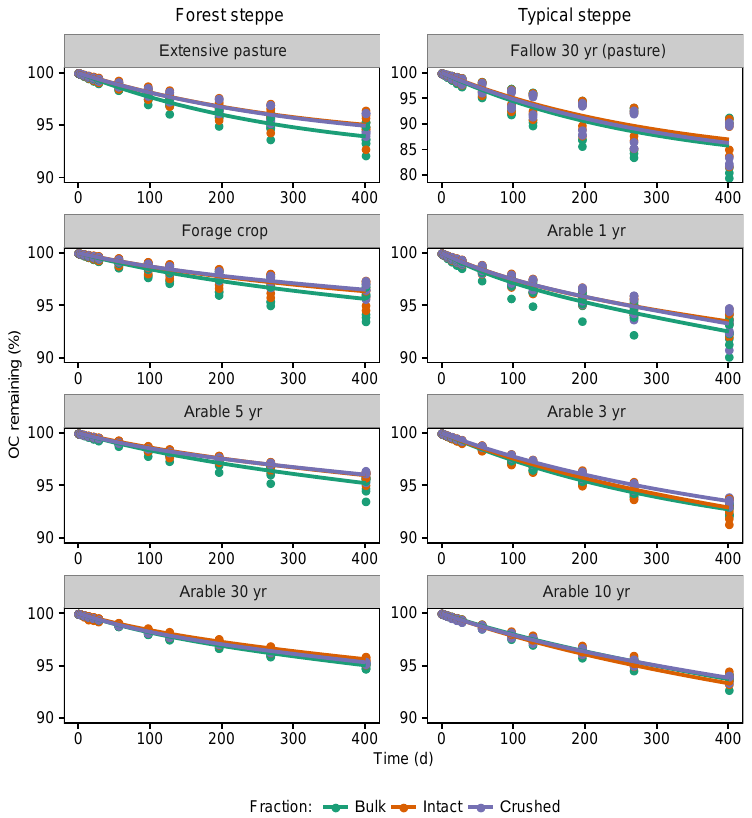
Figure 2. Percentage of soil OC remaining in the samples during 401 days of incubation for eight plots within two steppe types and for the three fractions bulk soil, intact macro-aggregates, and crushed macro-aggregates. For all plots a two-pool model (Eq. 2) was fitted, except for the extensively managed plots (extensive pasture and the fallow 30 years (pasture)), where an asymptotic two-pool model was fitted (Eq. 3). Note the different y scale for the fallow 30 years